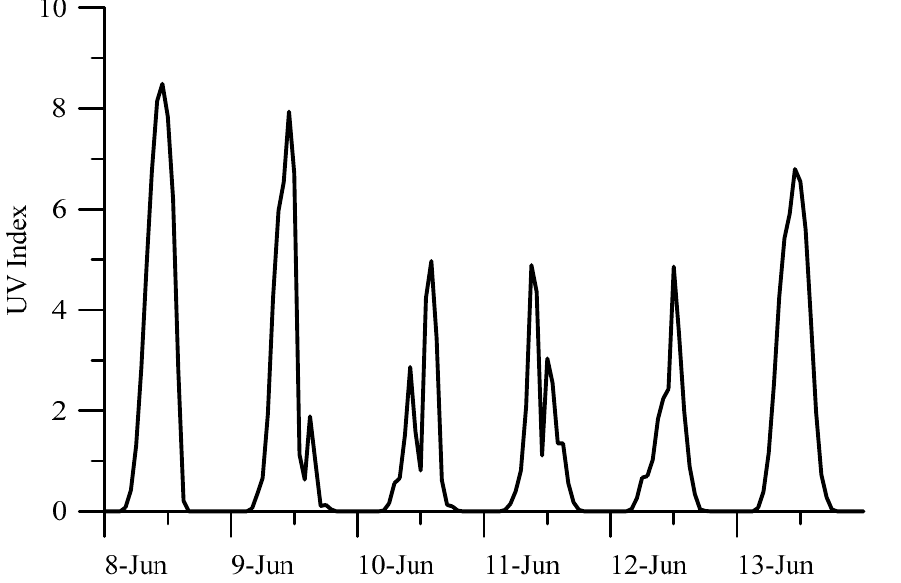
Figure 1. Behavior of the UV-Index from 8 to 13 June 2022 under variable weather conditions in the city of Sofia.